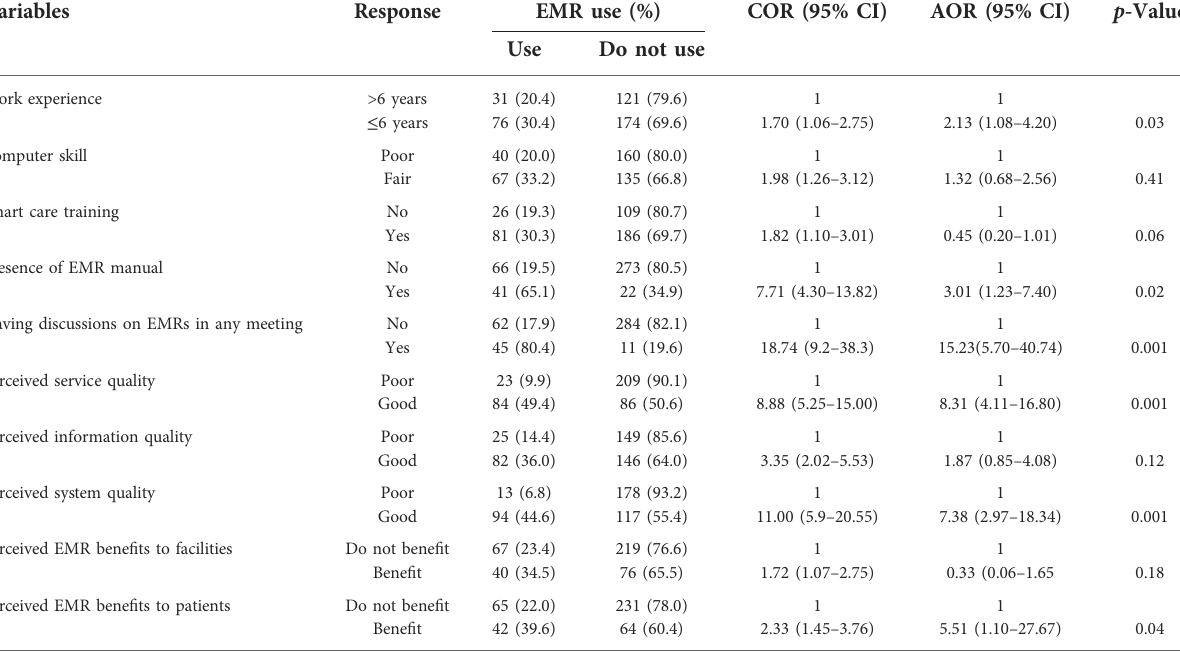
TABLE 3 Factors associated with EMR use by health professionals working in urban public health facilities, Dire Dawa, Ethiopia, 2019 ( n